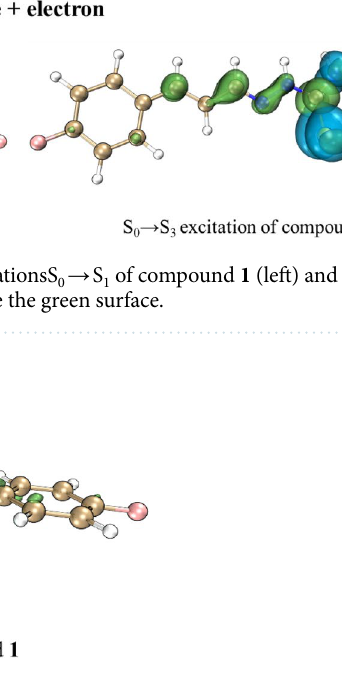
Figure 15. Hole + electron surfaces plot of excitation S 0 → S 2 of compound 1 . Hole are the blue surface and electron are the green